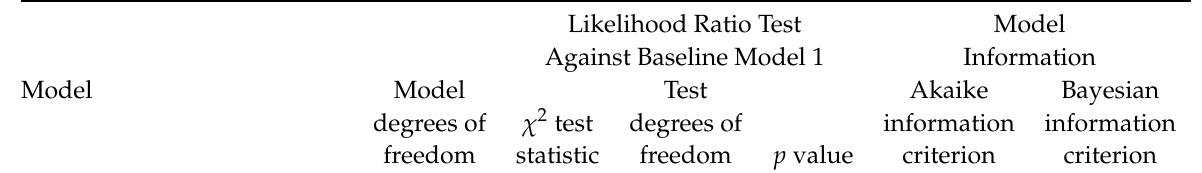
Table 3: Relative fit of six-period multinomial logit models of party